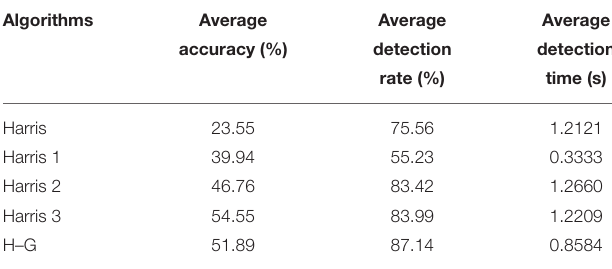
TABLE 2 | The average index value of the five algorithms of this study.